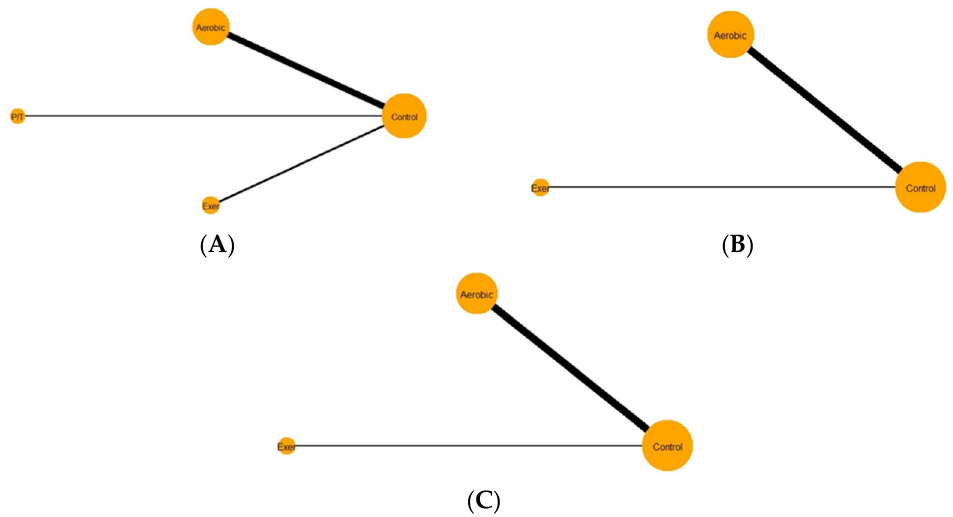
Figure 2. Network plot for object control ( A ), locomotor ( B ), and gross motor ( C ). Abbreviations: Exer = exergaming; P/T = parent/teacher education.